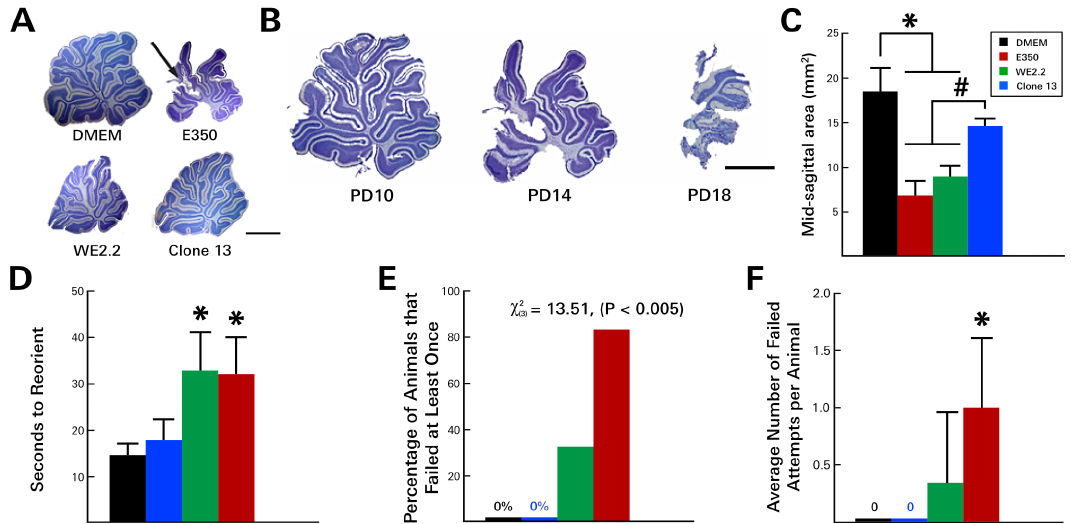
Figure 3. The di ff erent LCMV strains induced di ff erent cerebellar pathology and degrees of motor deficits. ( A ) Nissl-stained, 40-micron-thick sections through the midsagittal cerebellum on PD14. All three viral strains visibly reduced cerebellar size. However, only E350 induced destructive lesions (arrow). ( B ) The destruction of the cerebellum by E350 began at the tips of the dorsal lobules on PD10, then progressed to virtual total obliteration of the cerebellum by PD18. ( C ) Midsagittal areas of the cerebellum. E350 and WE2.2, but not Clone 13, significantly reduced cerebellar cross sectional area. In the rodent negative geotaxis assay, rat pups infected with E350 and WE2.2, but not Clone 13, took longer to reorient ( D ), had greater percentages of animals that failed ( E ), and had a greater number of failures per attempt ( F ). * Significantly di ff erent from DMEM ( p < 0.05). # Significantly di ff erent from Clone 13 ( p < 0.05). Scale bars represent 2 mm.